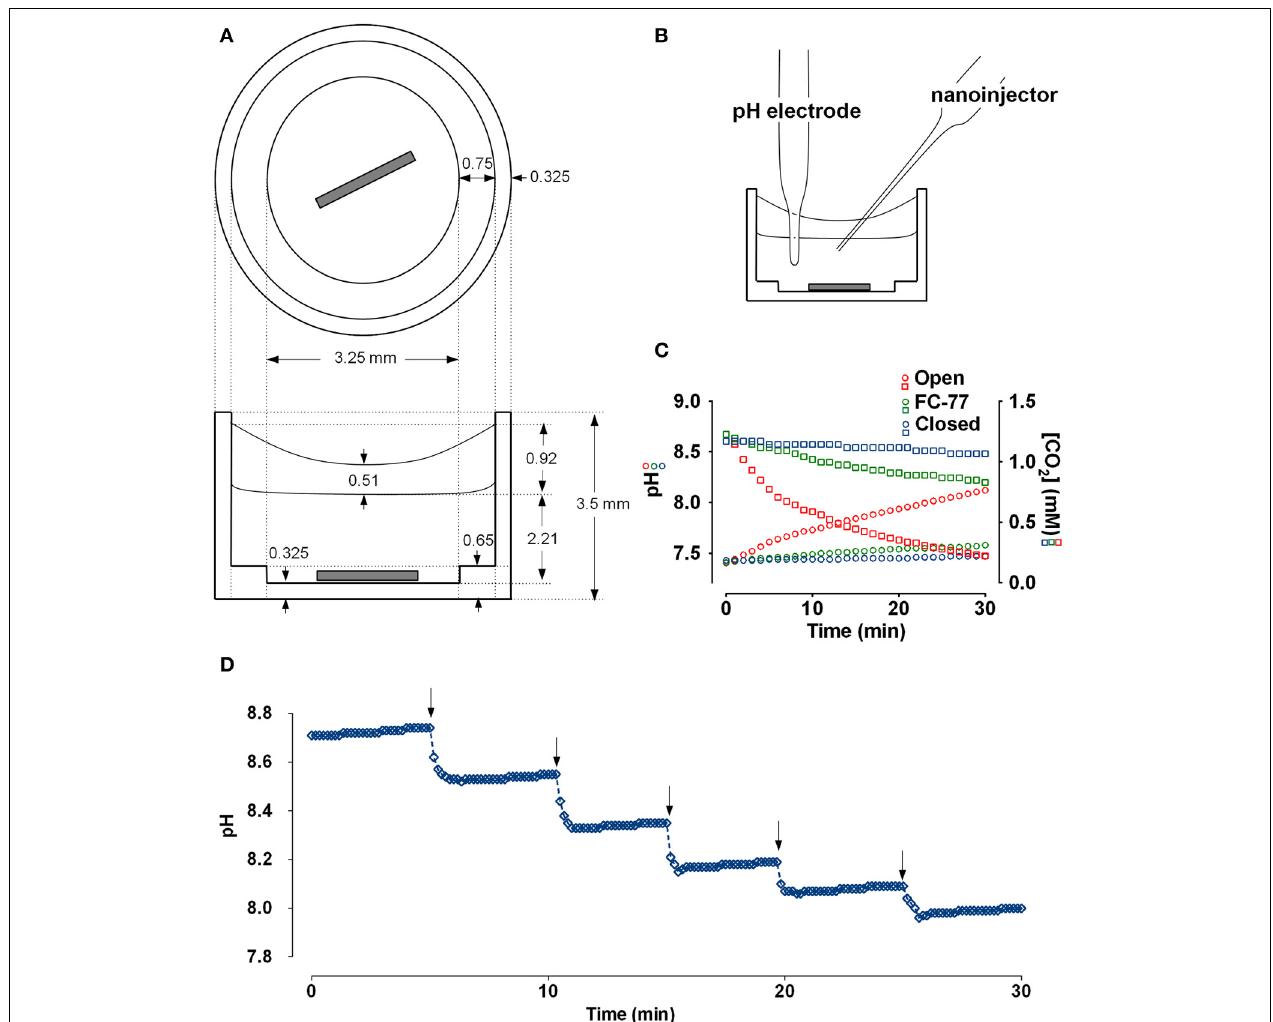
FIGURE 1 | Chamber schematic and characterization of the preparation. (A) Top and side views of the polypropylene chamber. The sample (30 μ l) was covered with a layer of FC-77 (10 μ l) and stirred continuously. (B) Chamber arranged for microtitration. Micromanipulators holding the pH electrode and nanoinjector are not shown. (C) Measurement of CO 2 efflux from the chamber under different conditions. An aliquot of 25mM NaHCO 3 solution (30 μ l) that had been equilibrated with 5% CO 2 was placed in the chamber and pH was measured at 1min intervals. The red symbols show the increase